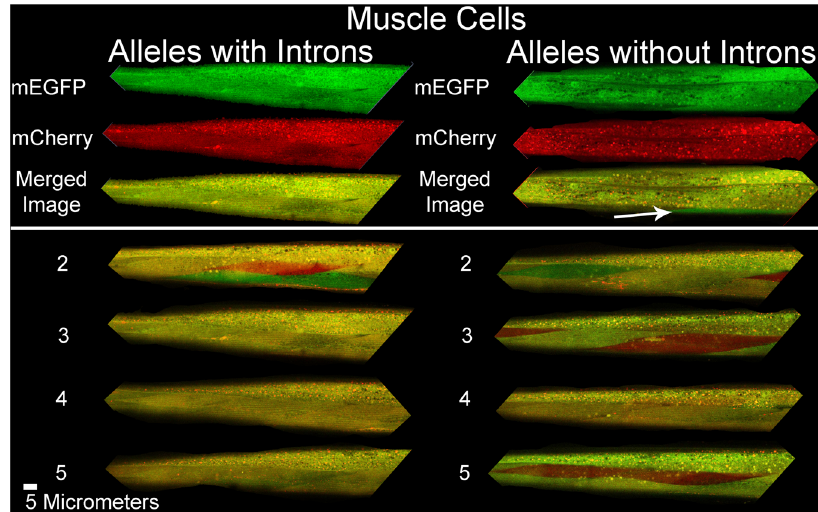
Fig. 3 Micrographs of stochastic allele bias in striated muscle cells. Composite images show merged red/green signal micrographs of animals expressing hsp-90 reporter alleles in their striated body wall muscles. Top panel shows the individual red signal, green signal and merged micrographs. Left column shows sections of animals with muscle cells expressing alleles with introns. Right column shows sections of animals with muscle cells expressing alleles without introns. We arbitrarily selected fi ve images per group from the z stacks from the three independent experiments used to generate the data in Fig. 2a.